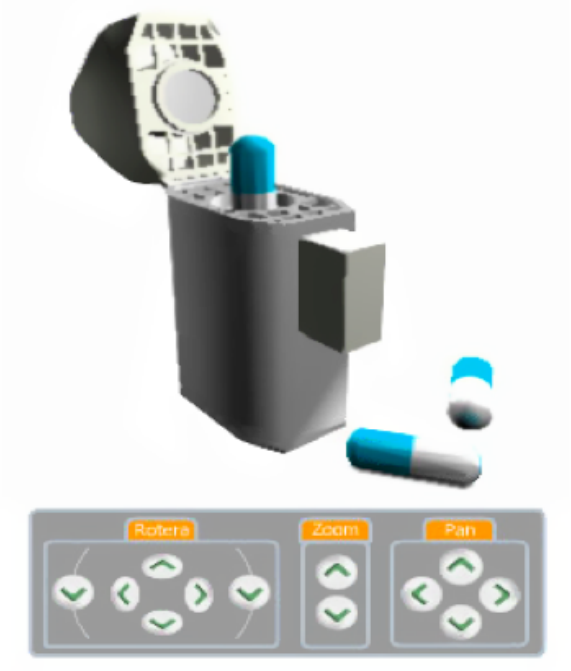
Figure 2. The Ingelheim asthma inhaler displayed using the first version of the 3-dimensional